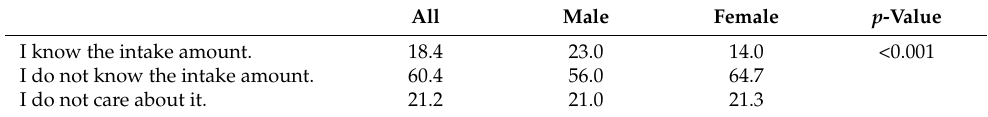
Table 14. The knowledge about the amount of mineral intake. All Male Female p